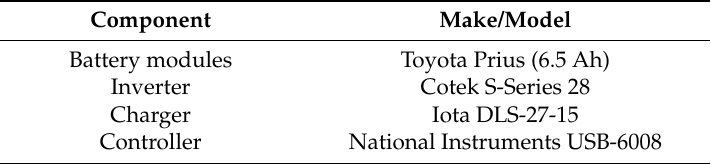
Table 7. Make/model of components of re-purposed battery